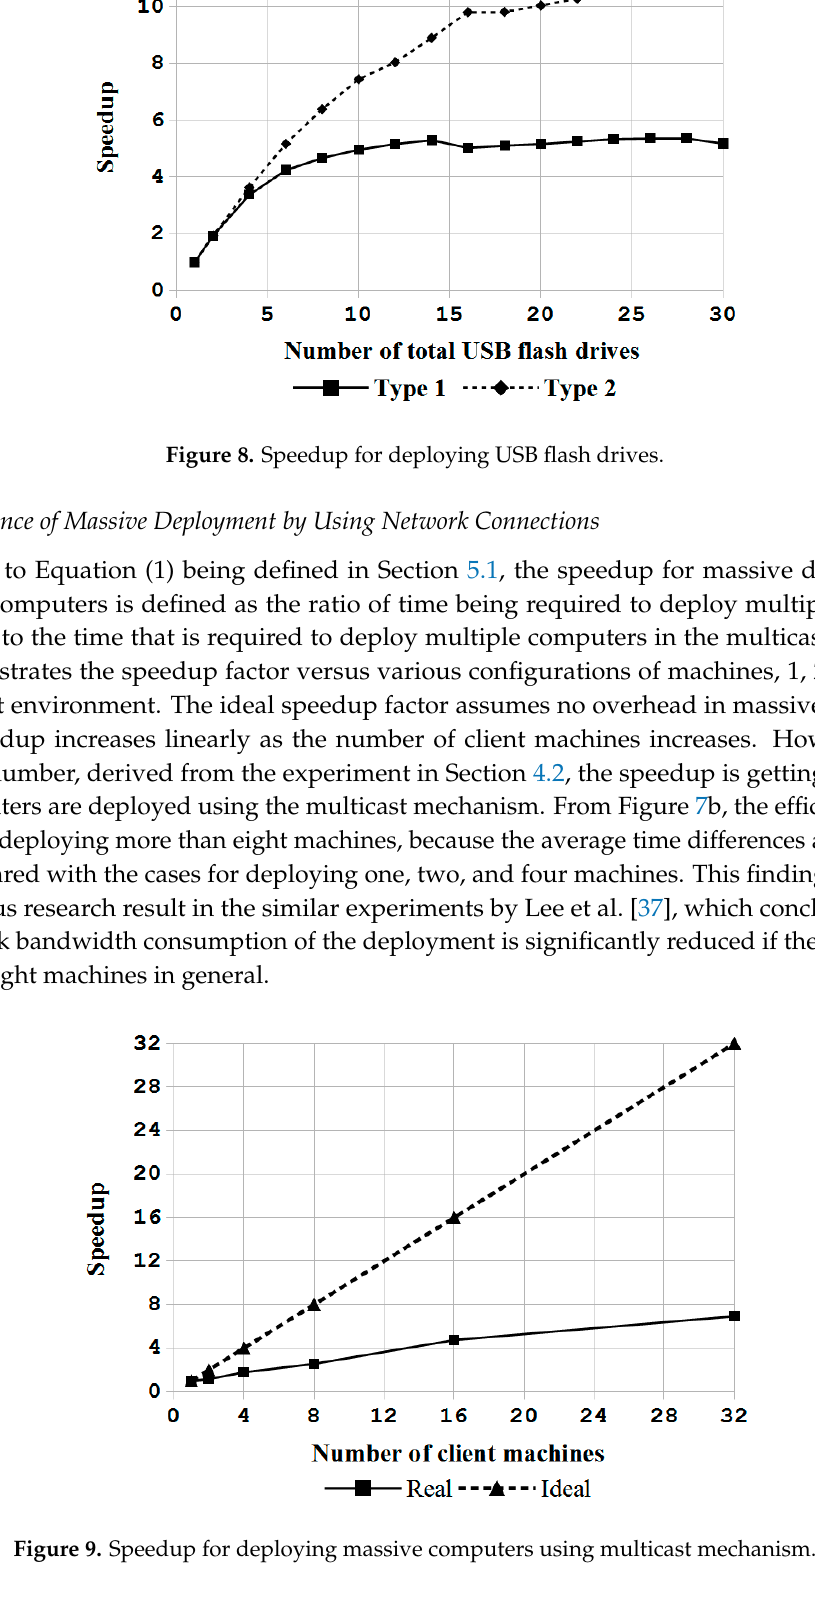
Figure 9. Speedup for deploying massive computers using multicast mechanism.